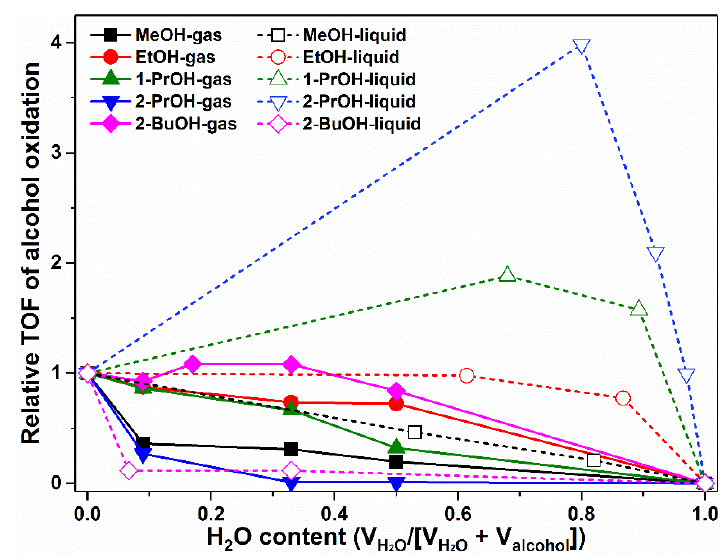
Figure 5. Effect of H 2 O addition on relative TOF of alcohol oxidations over Pt/MCF-17 in gas and liquid phases. Gas phase reaction: 1.33 kPa alcohol, 0.13–1.33 kPa water vapor, 6.67 kPa O 2 , He balance (in total 102.66 kPa); Liquid phase reaction: 5–10 mL alcohol, 0–10 mL distilled water, in total 15 mL volume, dissolved oxygen under 100 kPa for MeOH, EtOH, 1-PrOH, 2-PrOH and 300 kPa for 2-BuOH. Catalysts and reaction temperatures for both gas and liquid phases: 4 nm Pt/MCF-17 at 60 °C for MeOH, EtOH, 2-PrOH, 4.5 nm Pt/MCF-17 at 60 °C for 1-PrOH, and 6 nm Pt/MCF-17 at 80 °C for 2-BuOH. All data were normalized by TOF value without water addition. (H 2 O effect data for MeOH, EtOH, 1-PrOH, 2-PrOH, 2-BuOH oxidations were reported in [9,19–22], respectively).